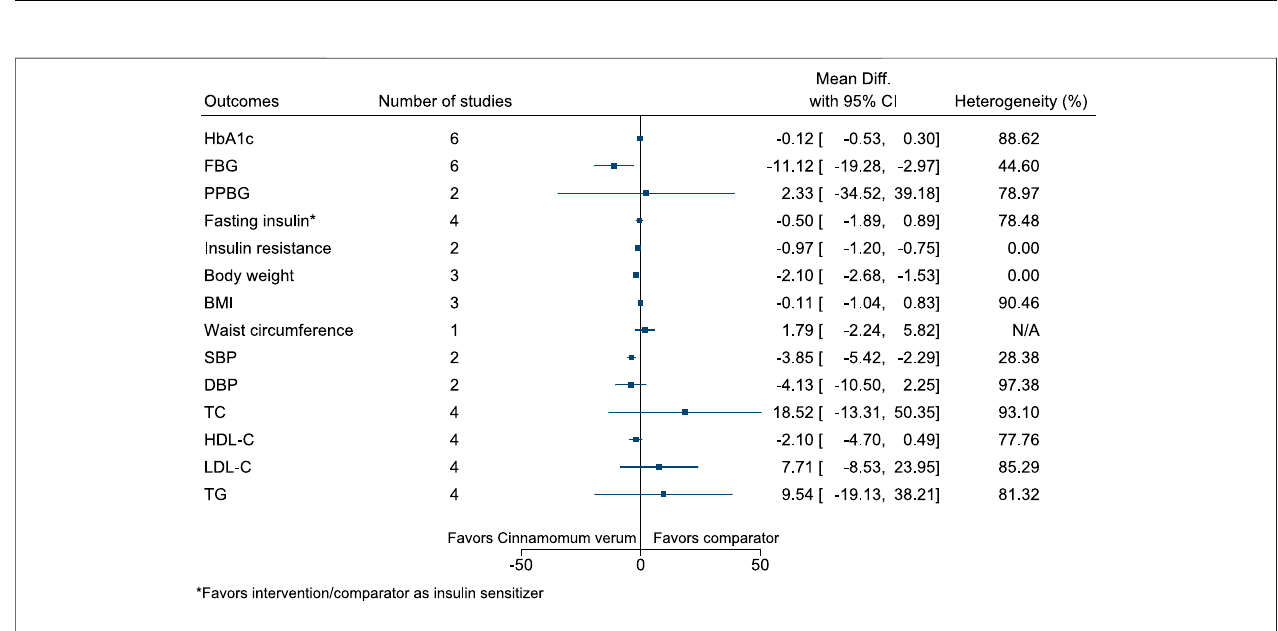
FIGURE 9 | Cinnamomum aromaticum — Summary forest plot.